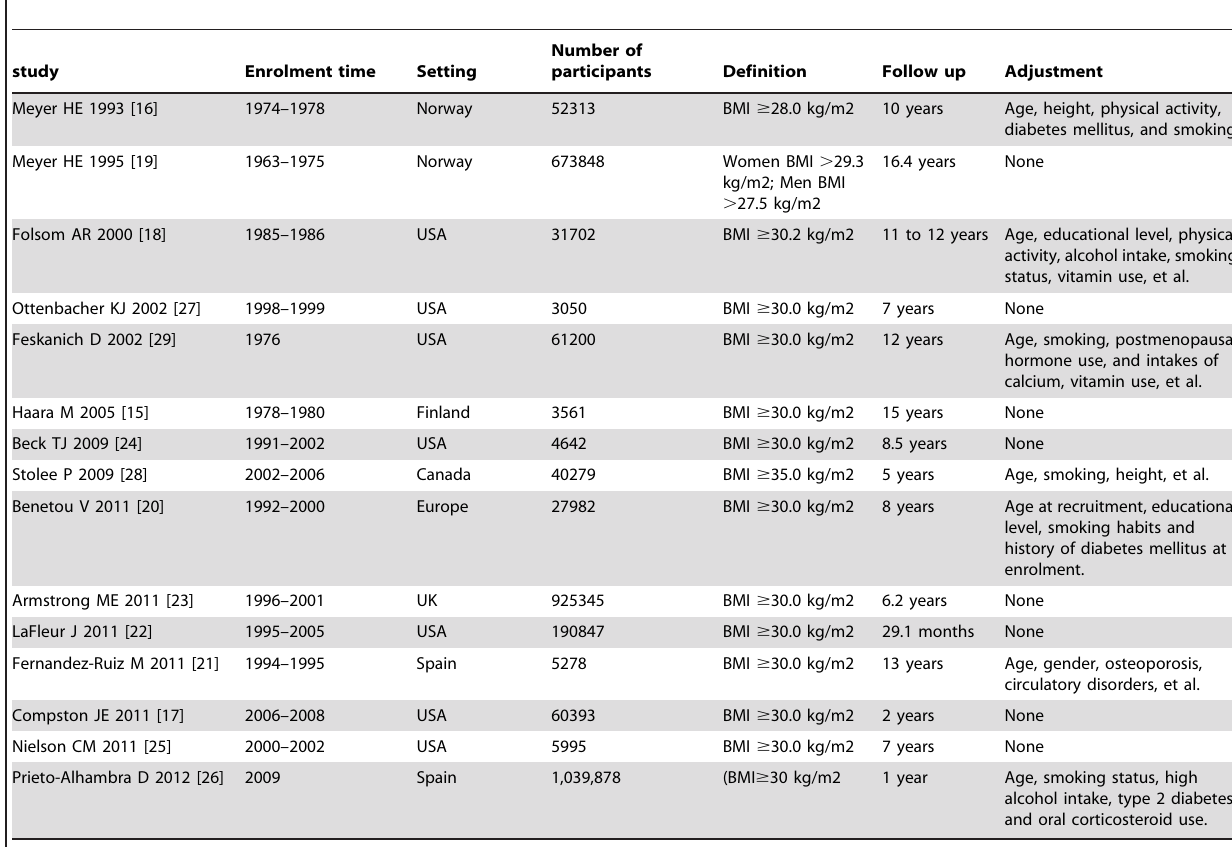
Table 1. Characteristics of 15 prospective cohort studies included into this